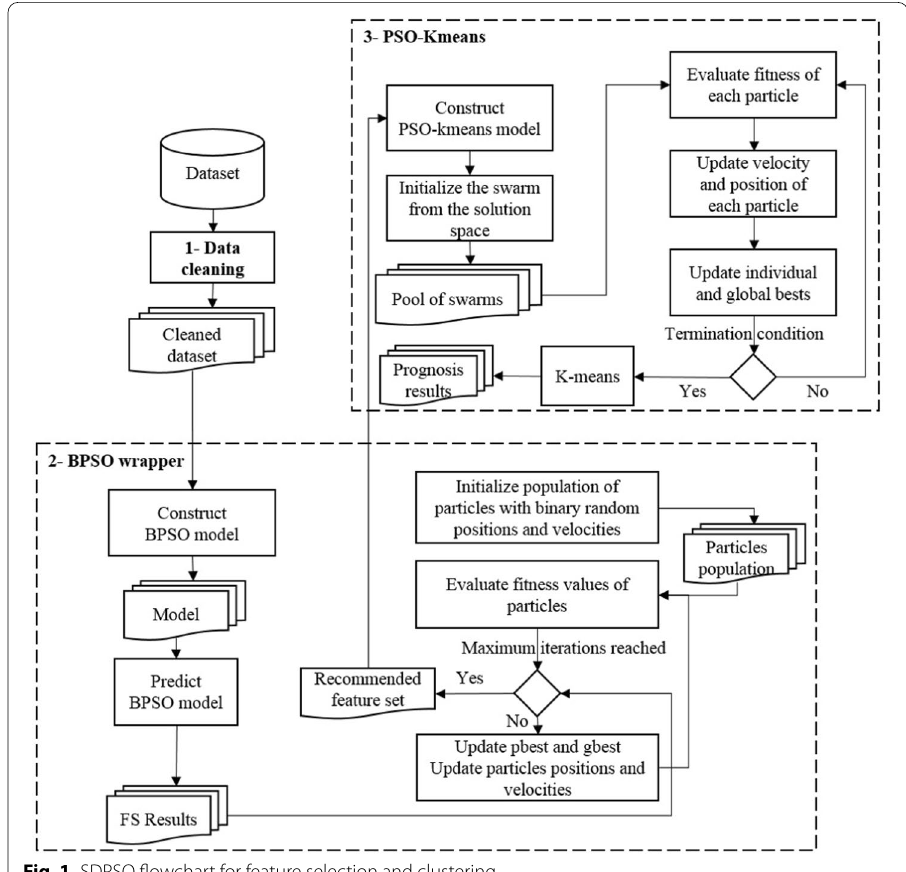
Fig. 1 SDPSO flowchart for feature selection and